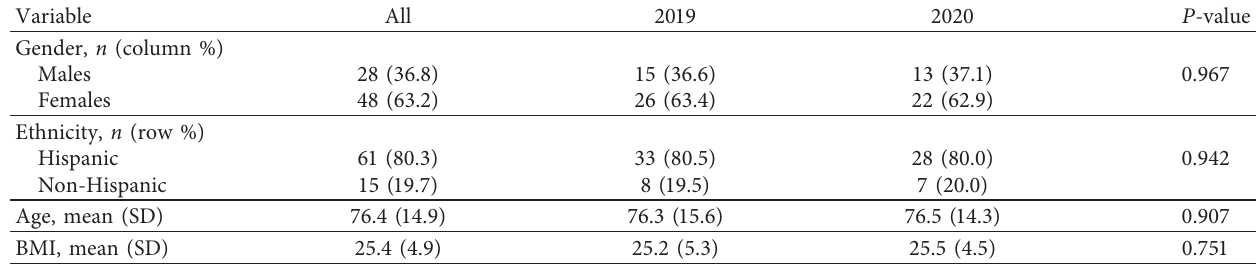
Table 1: Demographic characteristics of